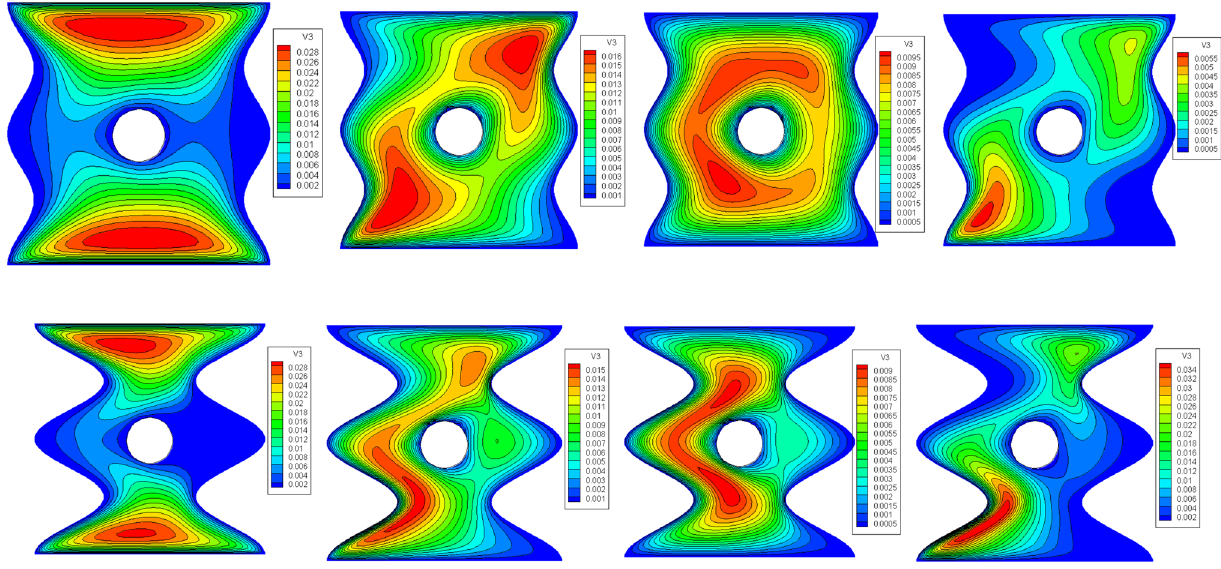
TiO –Cu/water hybrid nanofluid at the moderate values; Ha = 10 , 2 Q = 1 , Da = 10 – 3 , Ri = 1 , Gr = 1 , H * = 10 , R = 0 . 5 , ε = 0 . 5 , γ = 0 . 5 , Φ = π/ 3 , c d